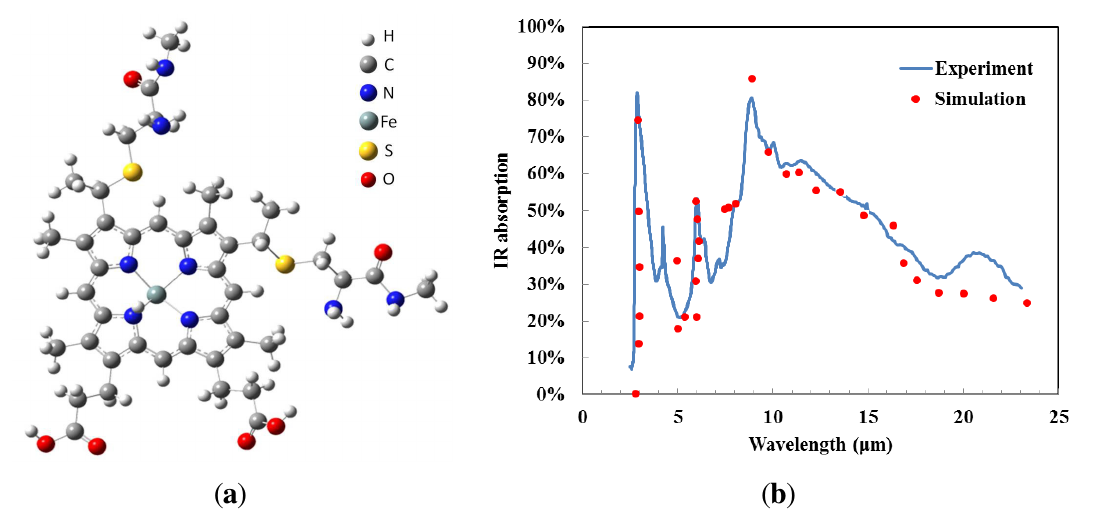
Figure 1. ( a ) The molecular structure of cytochrome c in GaussView ® . ( b ) The infrared absorption of the cytochrome c protein by software simulations and experimental